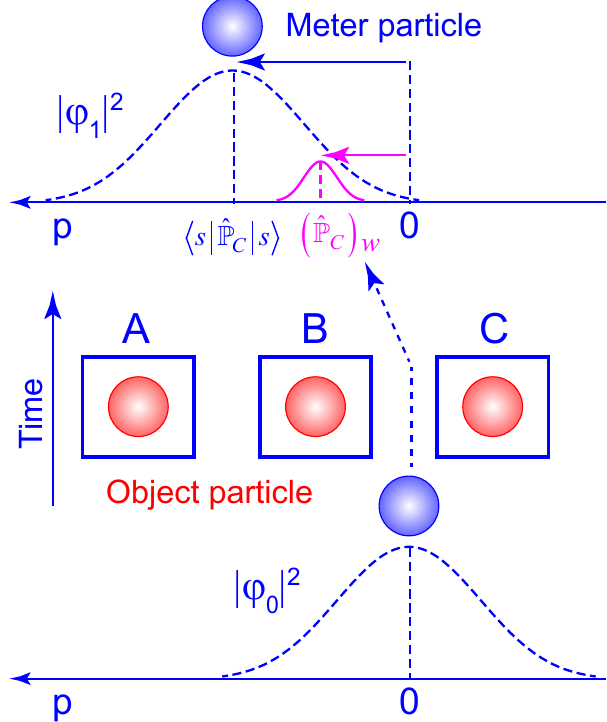
Figure 2: Schematic illustration of the setup of the Three-Box Paradox. Initially, the object particle in the boxes is pre- selected in the state | s (cid:105) = 1 √ ( | A (cid:105) + | B (cid:105) + | C (cid:105) ) . A test particle 3 acting as a meter is shot near box C to interact weakly with the object particle. After the meter particle has passed box C, its probability distribution | ϕ | 2 is recorded on a screen behind the three boxes. For g = 1 , the probability distribution is shifted by the amount (cid:104) s | ˆ P C | s (cid:105) with respect to the initial probability distribution. By selecting only a particular final state for the object particle, | f ( Θ ) (cid:105) = sin Θ 1 √ ( | A (cid:105) + | B (cid:105) ) + cos Θ | C (cid:105) , one 2 e ff ectively chooses only those positions for the meter particle that lie in a small band of this probability distribution and centered around the weak value (ˆ P C ) w